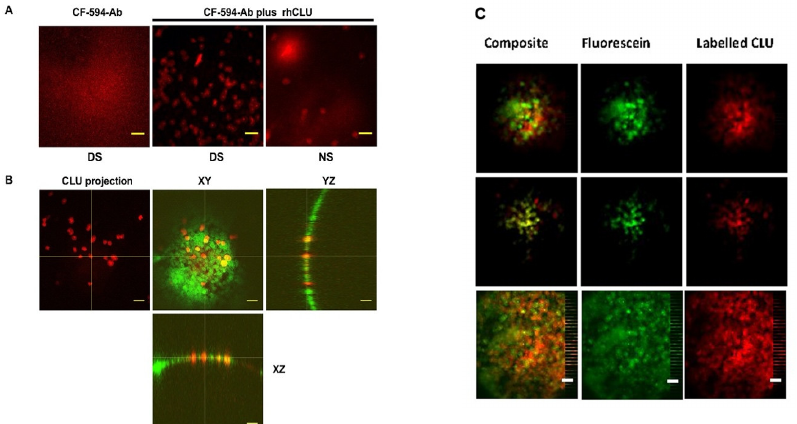
Figure 3. CLU binding to the ocular surface. ( A ) The standard desiccating stress protocol was applied for five days to create ocular surface damage. Nonstressed (NS) mice housed under normal ambient conditions were included for comparison. Eyes were treated with CF-594-anti-His antibody that binds to the His tag of recombinant human CLU (rhCLU), or with a complex of the antibody-rhCLU for 15 min, followed by confocal imaging of central cornea. ( B ) An eye subjected to DS was treated with a complex of the antibody-rhCLU (red) as in ( A ), as well as a fluorescent membrane tracer DiO (green). Images were taken at 20 × magnification. In the left panel only CLU was projected. The right three panels show one Z-section plane with cross-sections oriented to the XY, YZ, and XZ axes, generated using Image J software. Yellow indicates regions of co-localization of the red and green signal. ( C ) On the morning of the 6th day after the DS protocol was begun, labeled CLU was mixed with clinical fluorescein dye Fluoresoft ® -0.35% (Holles Laboratory, Cohasset, MA; 2 µ L CLU + 1 µ L fluorescein) and then 2 µ L of the resulting mixture instilled to the OcS for 15 min. Eyes were then removed and the OCS was imaged by confocal microscopy with simultaneous two-color excitation (10 × magnification). Fluorescein and CLU were distinguished by the color of fluorescence emission (far-red for CLU, green for fluorescein, please note difference from Fig 1B, where green is DiQ). The three rows represent different focal planes on a single cornea. 10 × magnification. Scale bar = 100 µ m; ( A , B ) from (79) CC-BY; used with permission from the publisher.